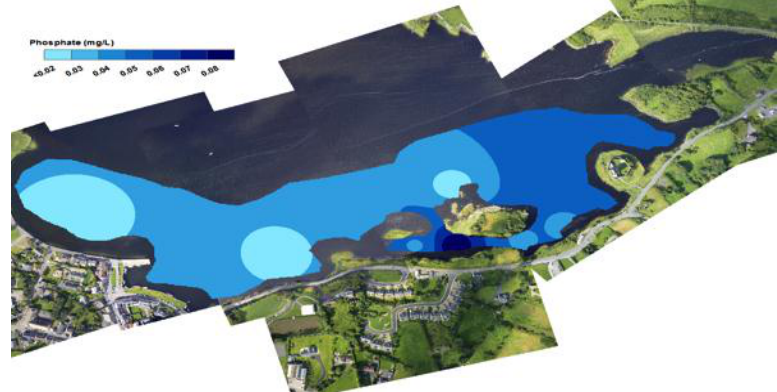
Figure 14. Interpolations of Nitrite ( top ), Nitrate ( middle ) and Phosphate ( bottom ) within Kinvara Bay at low tide during the sampling campaign (25–28 August 2015).